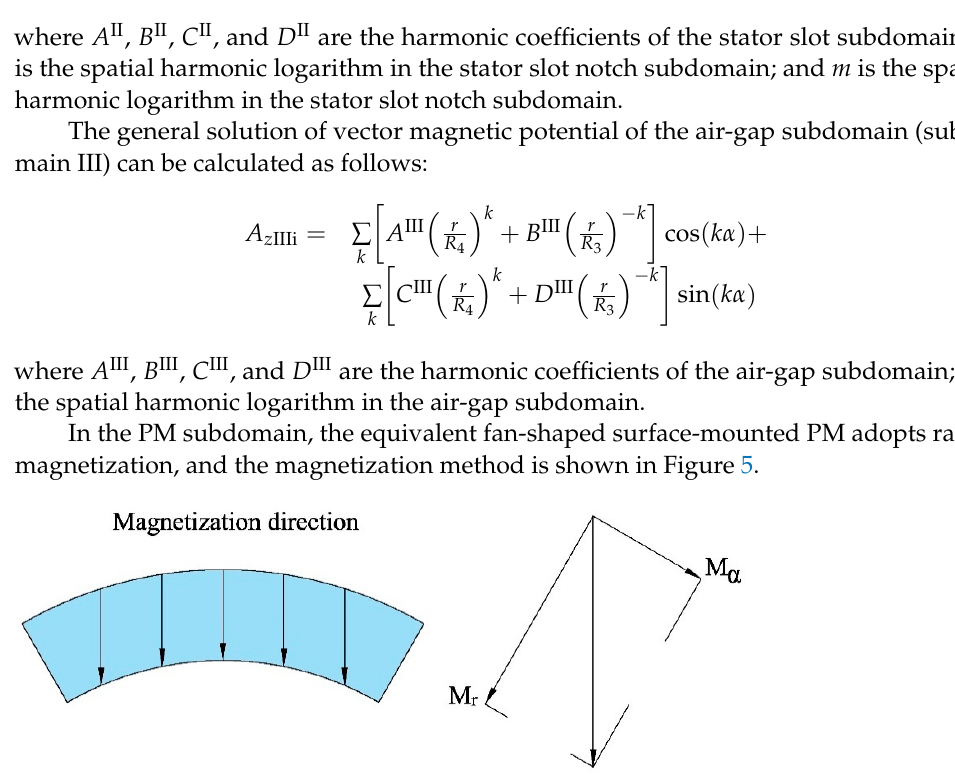
Figure 5. The magnetization method of PM.